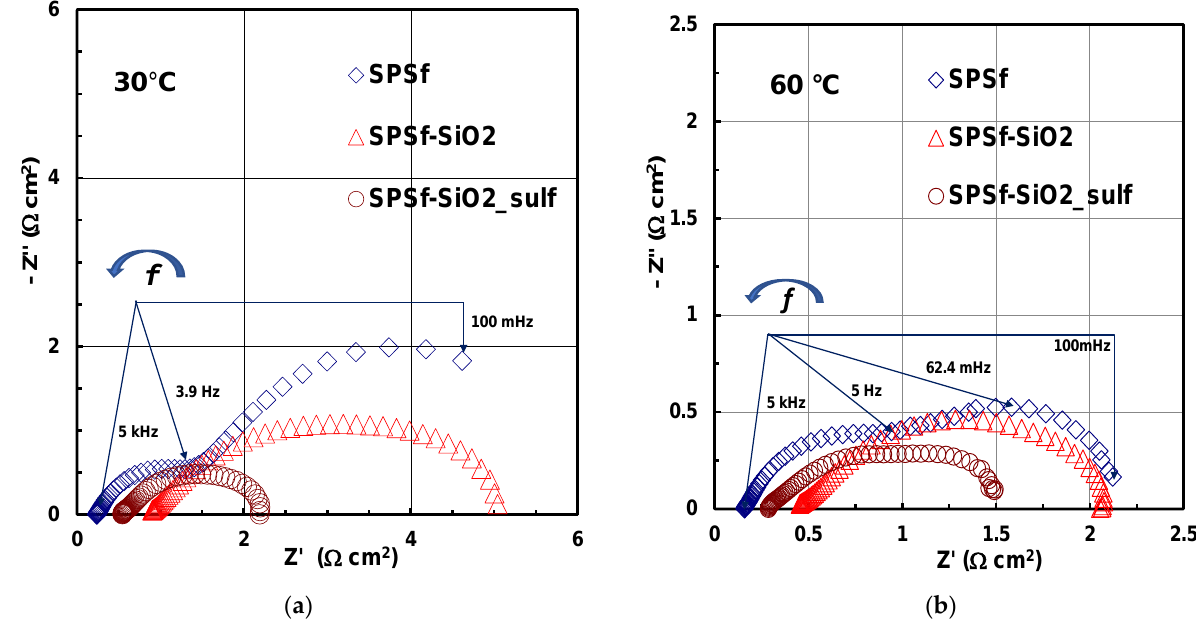
Figure 6. Electrochemical impedance spectra (Nyquist plots) for the MEAs equipped with the different membranes recorded at 0.3 V and 5 M MeOH solution at ( a ) 30 °C and ( b ) 60 °C.